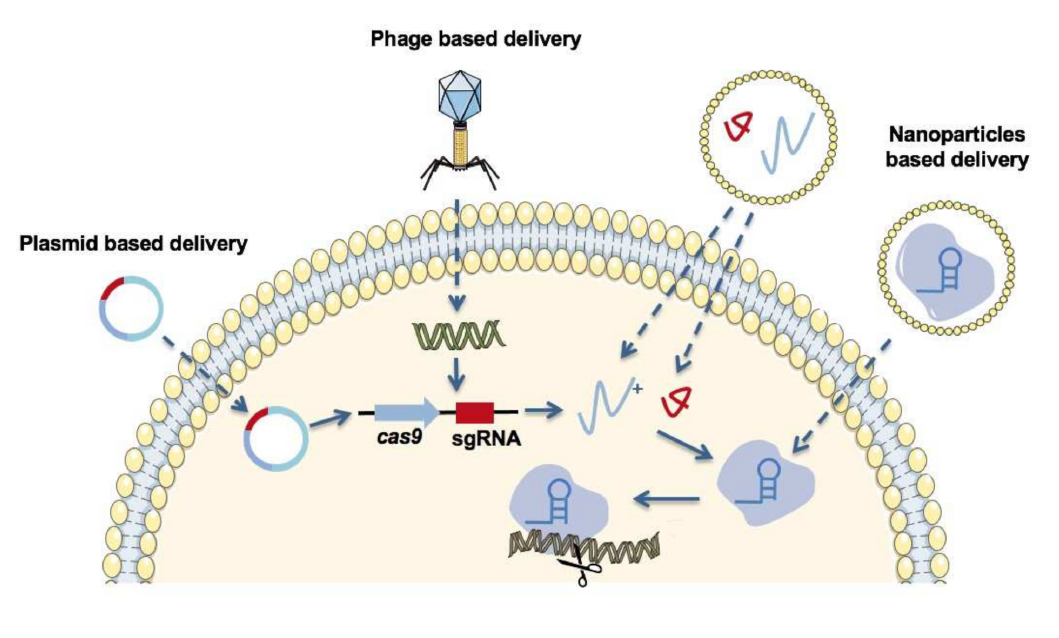
Figure 4. Different strategies for CRISPR-Cas9 system delivery to edit genes. Plasmid-based delivery: The plasmid-borne CRISPR-Cas system can be transferred into cells and transcribed into Cas9 mRNA and sgRNA. Cas9 mRNA is translated into the Cas9 protein, which forms a ribonucleoprotein (RNP) complex with sgRNA. Then, the RNP complex edits the target genes directed by sgRNA. Phage-based delivery: CRISPR-Cas system coding sequences are delivered by phages into cells. Nanoparticle-based delivery: Cas9 and sgRNA can be delivered either in the form of mRNA or Cas9-sgRNA ribonucleoprotein (RNP) complexes with the help of